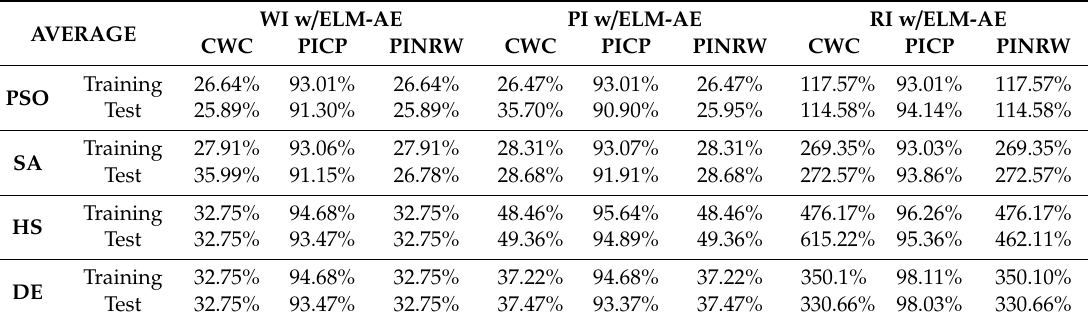
Table 2. Comparison of average results of di ff erent cases with